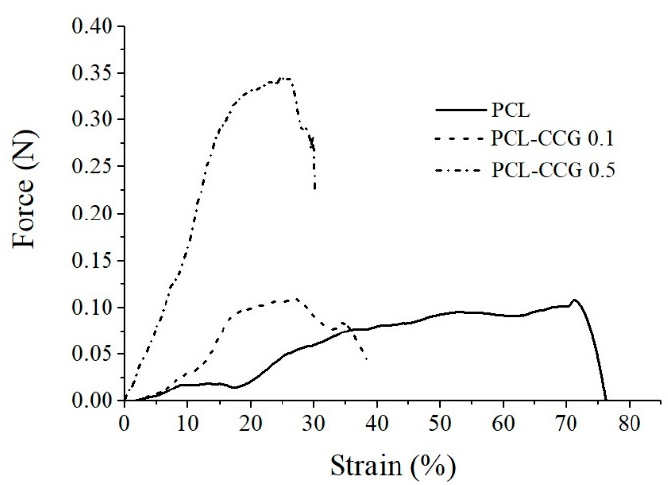
Figure 7. Stress–strain curves of PCL and PCL composite scaffolds.